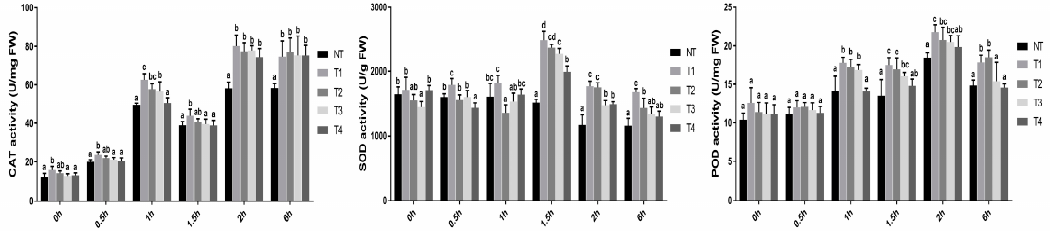
Figure 6. Catalase (CAT), superoxide dismutase (SOD), and peroxidase (POD) activities of four transgenic poplar lines (T1, T2, T3, and T4) and non-transgenic (NT) poplar. Three-year-old soil-grown poplar plants were subjected to 0.8% w / v NaCl at different time points (0, 0.5, 1, 1.5, 2, and 6 h). Data were analyzed using one-way ANOVA followed by Duncan’s test. Error bars with letters represent significant differences ( p < 0.05, Duncan’s test).